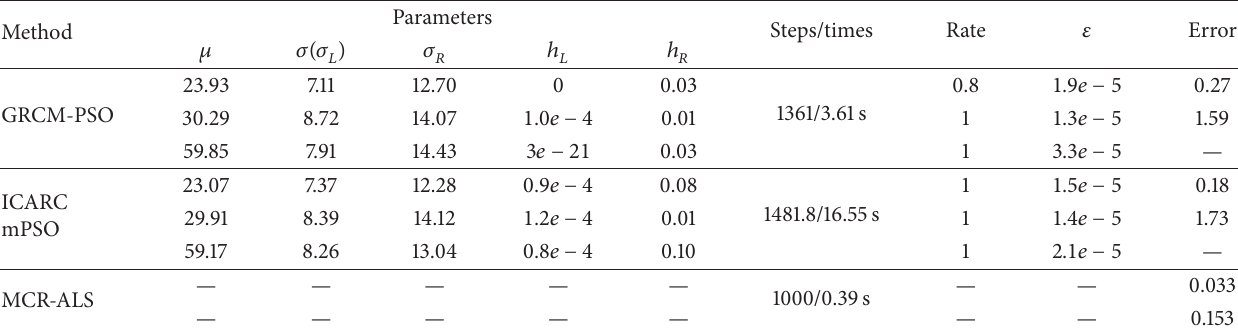
Table 2: The calculated results for the experiments. The column of “Rate” indicates the rate for this parameter emerging among the total ten candidates. The column of “Error” represents the error between the calculated spectra and the true